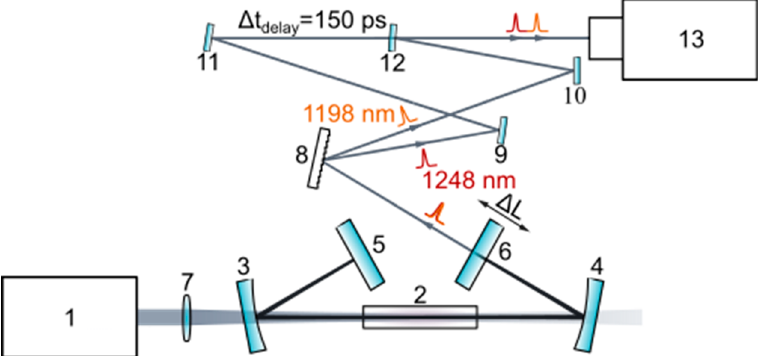
Figure 1. Experimental setup.